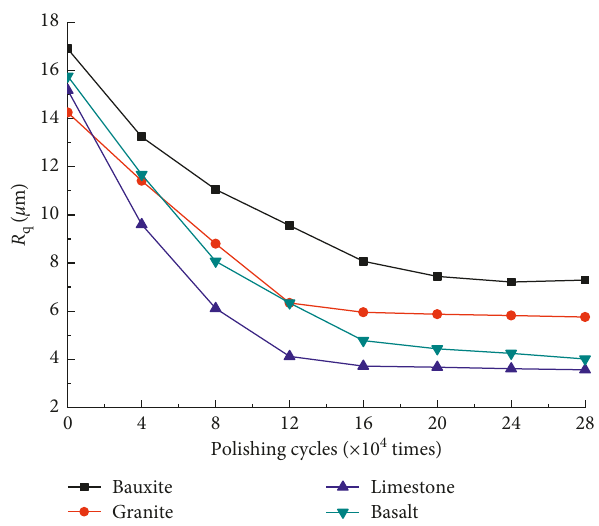
Figure 6: Variation of R q during the long-term polishing process.